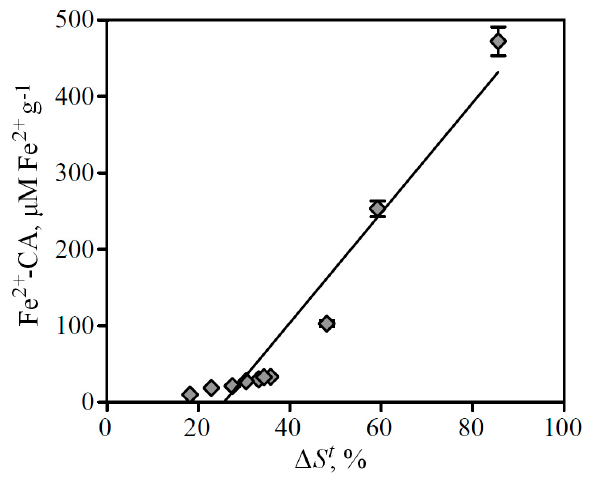
Figure 6. Correlation between values of Fe-CA determined by FeCA-HPLC ( Δ S t ) and spectrophotometry (Fe 2+